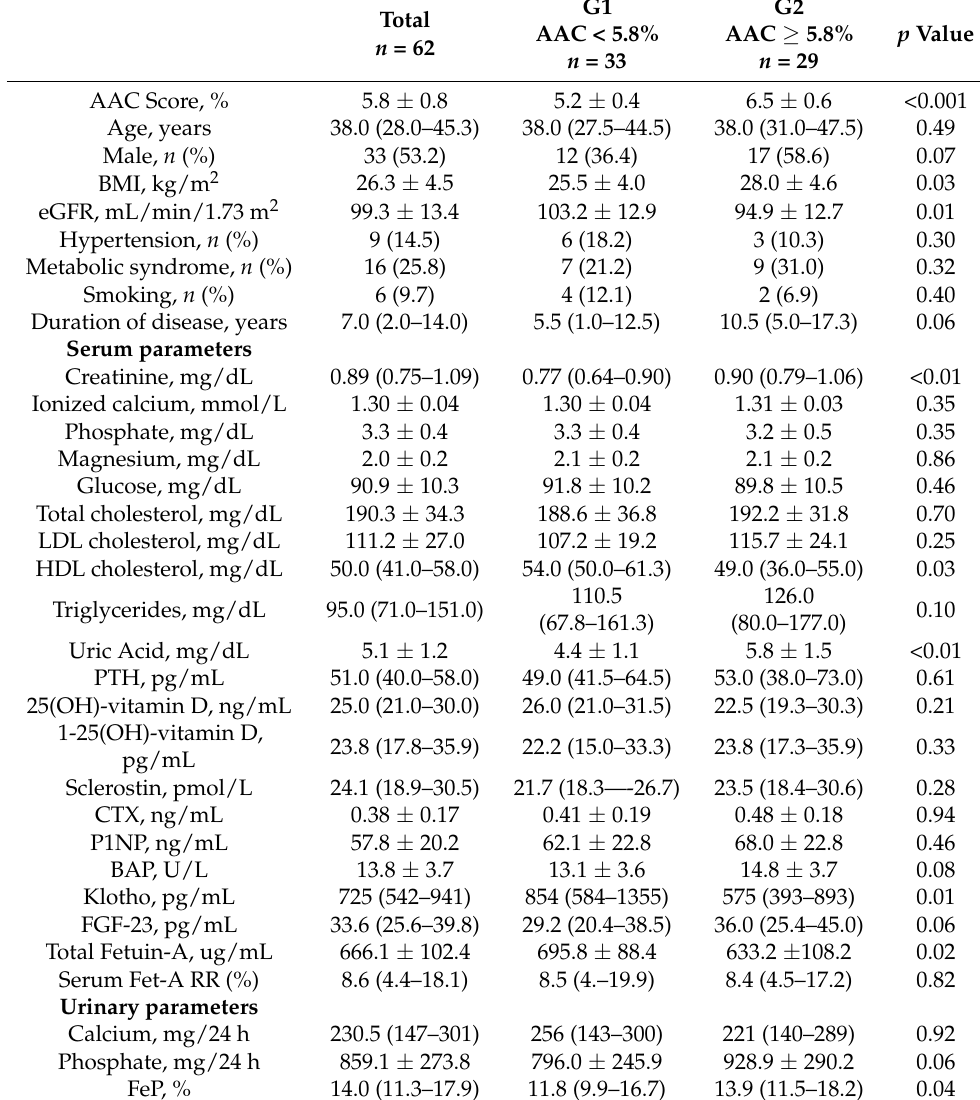
Table 2. Demographic, laboratorial, and bone microarchitecture parameters of SF divided according to their mean